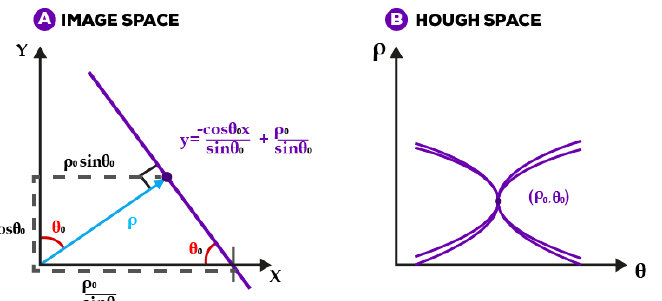
Figure 4. Hough transform converts the Cartesian representation of points in image ( A ) to polar coordinates, as shown in ( B ). By identifying clusters of points with similar polar coordinates, this transformation allows for the detection of lines in the image according to specified parameters.